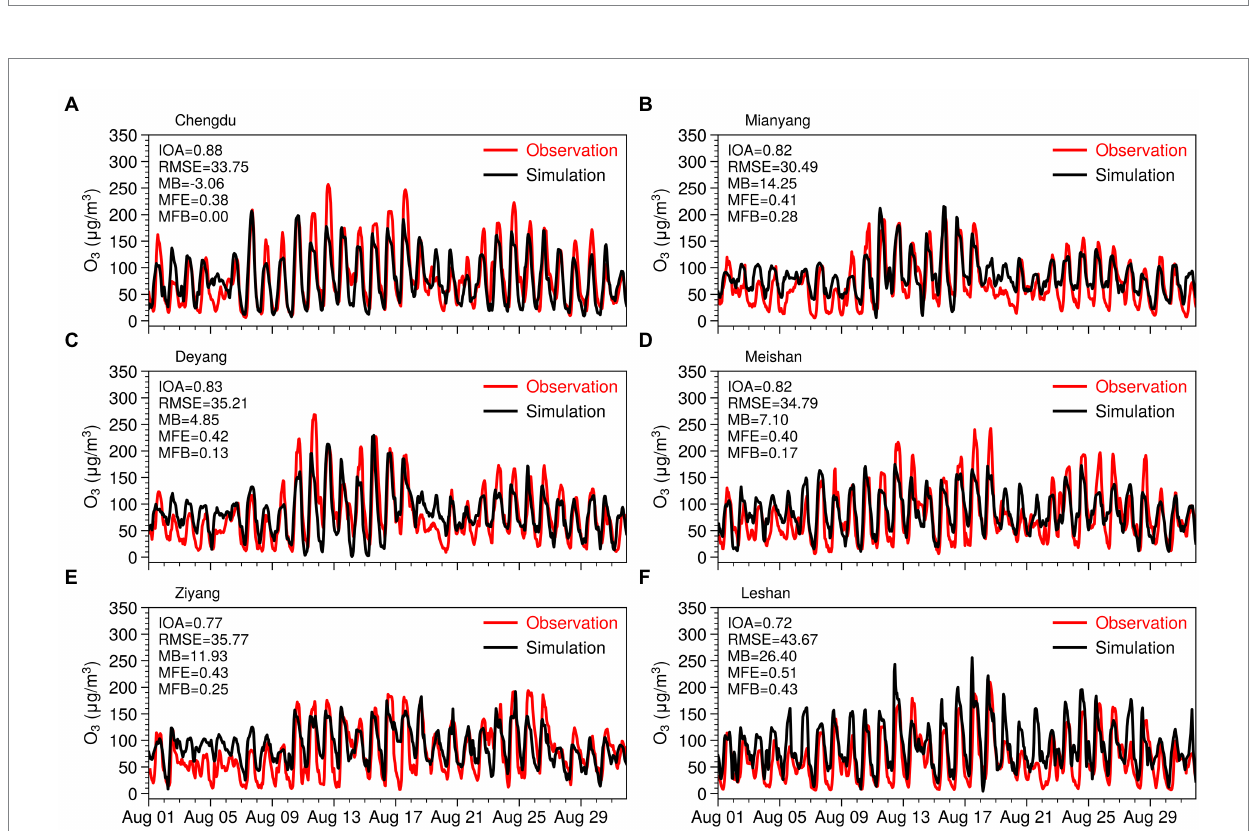
FIGURE 3 Time series of observed and simulated ambient O 3 for cities within the SCB in August 2019.